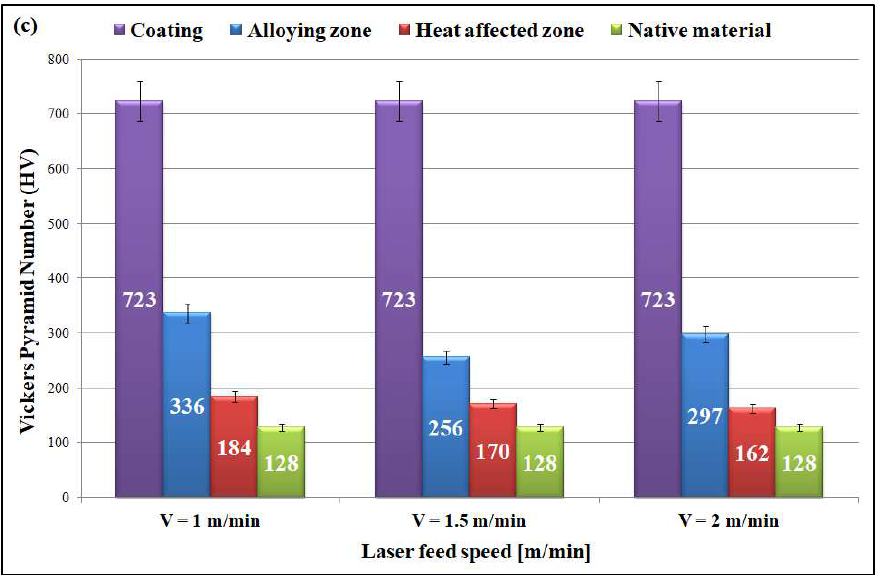
Figure 16. Summary of the results of hardness measurements: ( a ) sample 1; ( b ) sample 2; ( c ) sample 3. Two-way ANOVA with a linear model for two explanatory variables, lambda (share of AISI316L) and rate (rate of laser alloying process), was applied to the measured hardness of AZ (Table 13) and hardness of HAZ values (Table 14). The plots of the marginal means are provided in Figure 17 (AZ) and Figure 18 (HAZ), respectively. Table 13. ANOVA of AZ hardness with respect to the lambda and rate explanatory variables.